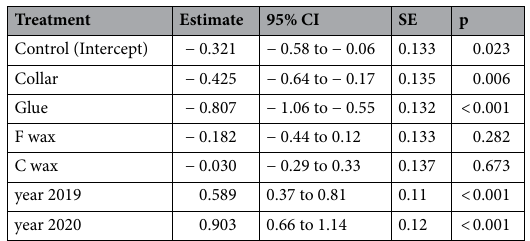
Table 4. Results of mixed linear models (LMMs) relating seedling damage to five treatments (excluding the chemical treatment) at the clear-cut site.